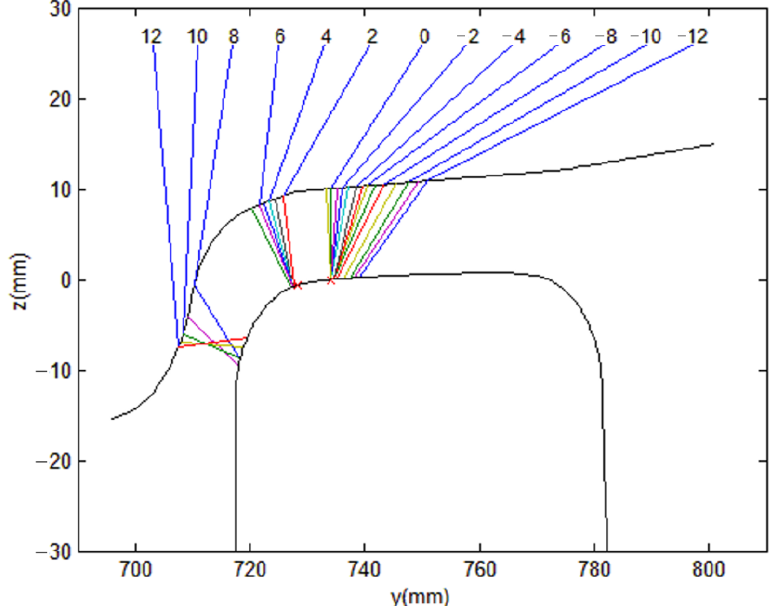
Figure 10. Position of contact points on wheel and rail depending on lateral displacement of wheelset (surface fatigue-optimized wheel profile).